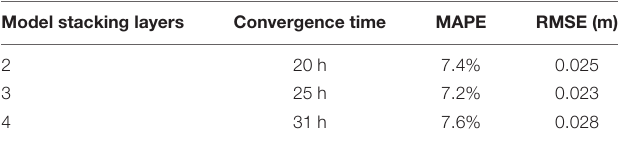
TABLE 3 | Number of stacking layers.